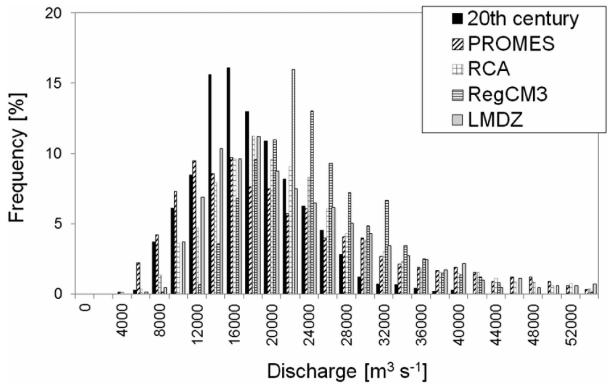
Figure 6. Sediment volume per year from LUFM modelling for corresponding flow discharge classes at Corrientes, characterizing past and future